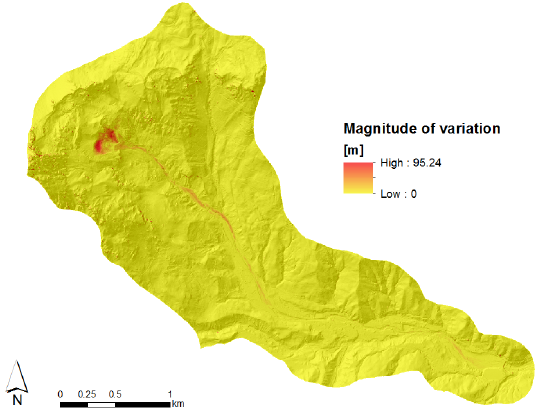
Figure 2. Magnitude of geomorphic change in the Rotolon catch-